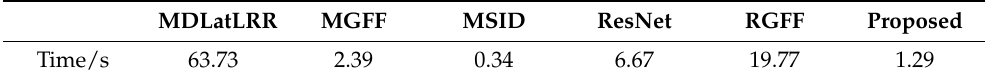
Table 2. Average time consumption of the six fusion